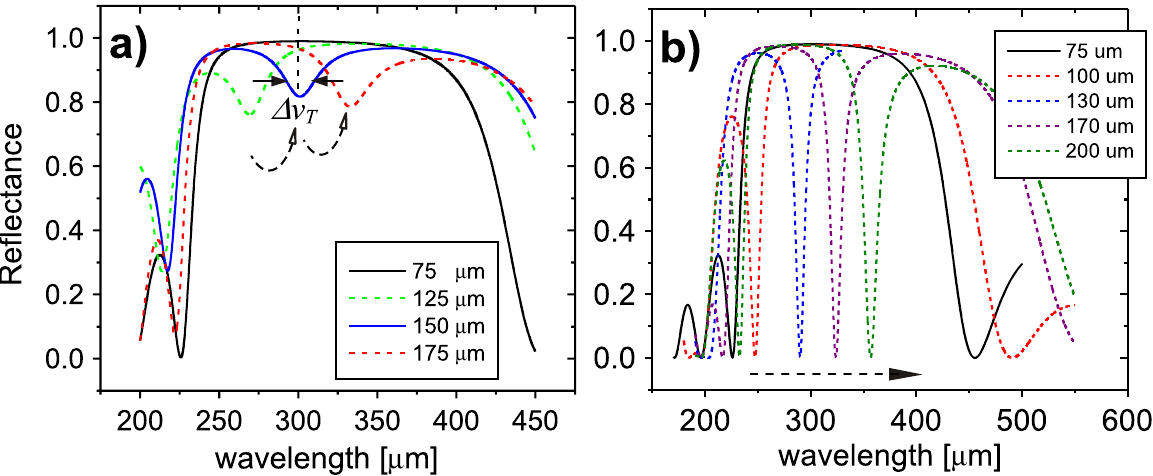
FIG. 4. (Color) Transmission peaks within the reflectivity band vs defect layer thickness. In (a) the outermost quartz wafer of a four layer stack with the sequence ( 3 þ 1 ) is displaced from the equidistant position ( 75 (cid:6) m ) while in (b) the center defect layer is surrounded by two-layer stacks ( 2 þ 2 ). In the latter case the fractional bandwidth of the associated transmission peak amounts to (cid:1) 3 : 5 (cid:7) 10 (cid:2) 2 =(cid:7) (cid:2) (cid:7) T C